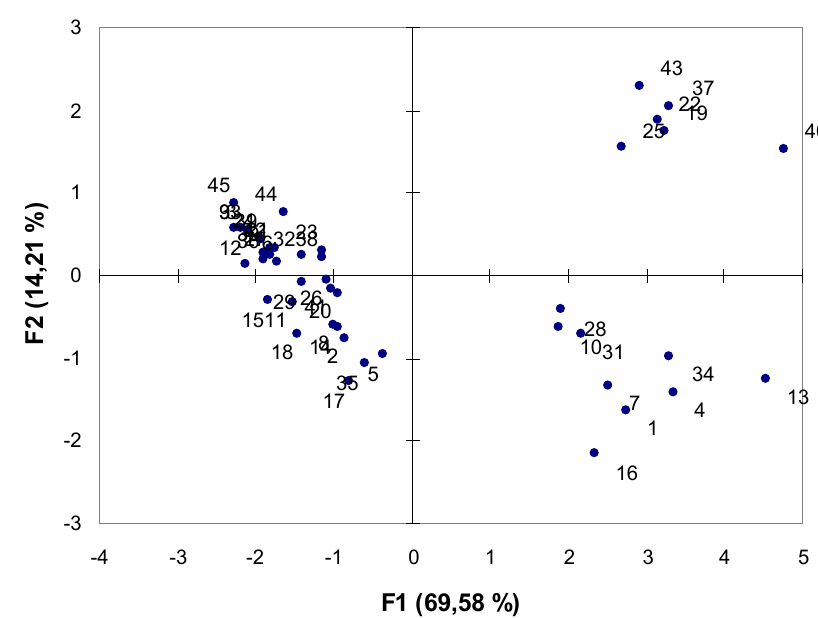
Figure 2. Principal component F1-F2 plot. Labeling: 1 means that it is the first sample from Table